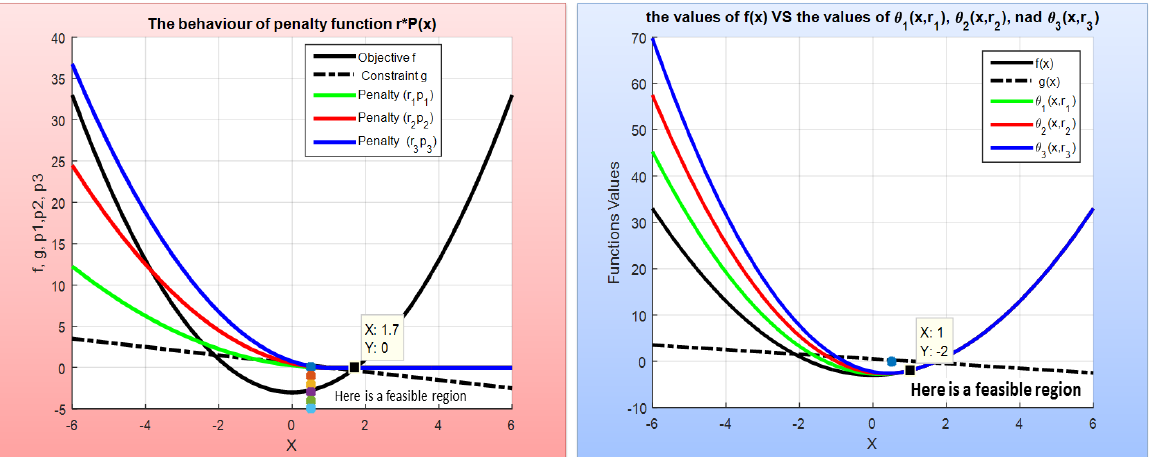
Figure 1. Penalty function rp ( x ) converges to zero VS f ( x ) → − 2 and θ ( r , x ) → − 2 that is the optimal solution of the constrained problem.